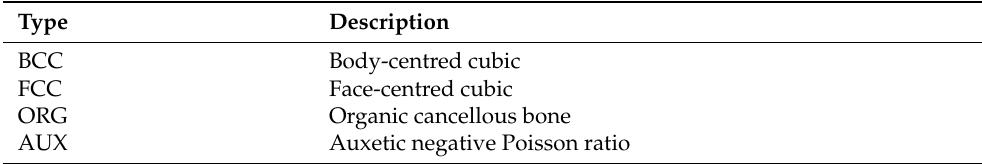
Table 3. Summary of acronyms for the four lattice topologies used.